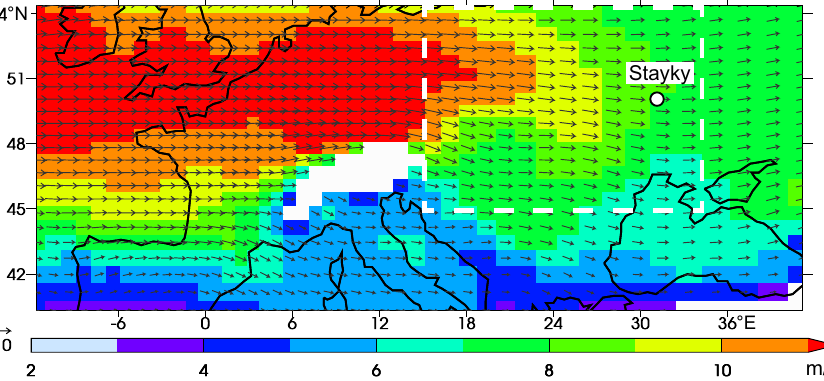
Fig. 2. Mean annual 850hPa wind speed and direction for the reference GS state (modified from Rousseau et al., 2011). The area investigated in this study stretches between 15–35 ◦ E and 45–55 ◦